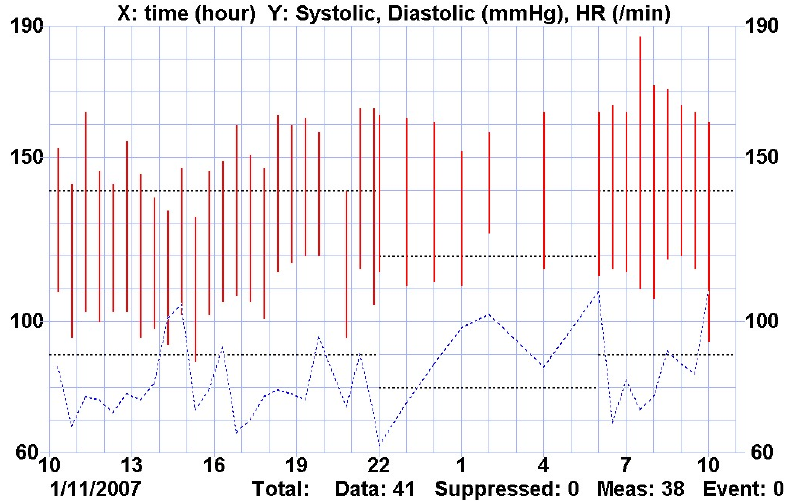
Figure 10. Holter BP.